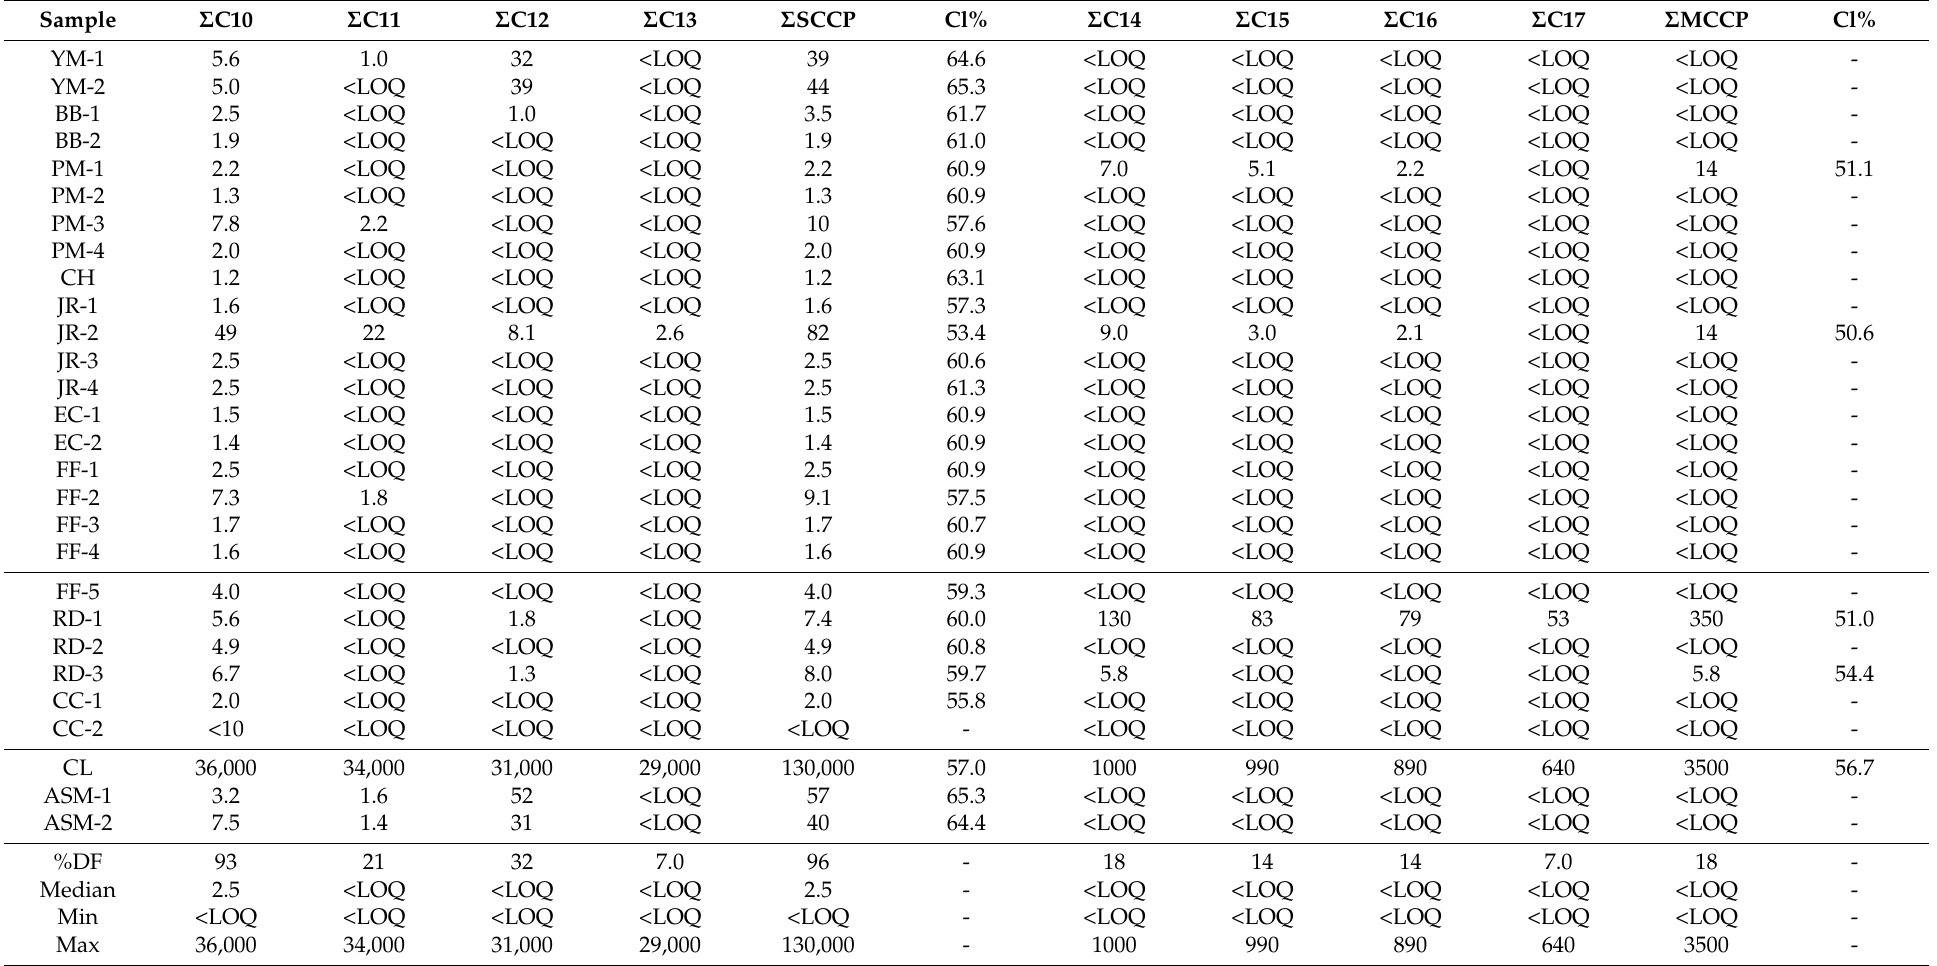
Table 2. Summary concentrations of short-chain chlorinated paraffins (SCCPs) and medium-chain chlorinated paraffins (MCCPs) in consumer product and toy samples ( µ g/g).